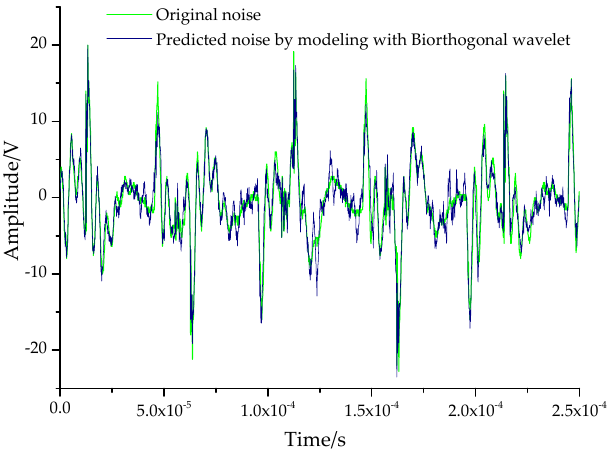
Figure 8. The comparison of time-domain waveforms before and after modeling with the Haar wavelet.